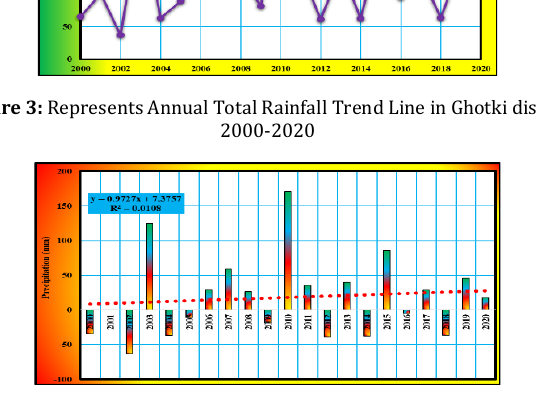
Figure 4: Annual Rainfall Deviation in Ghotki district 2000-2020